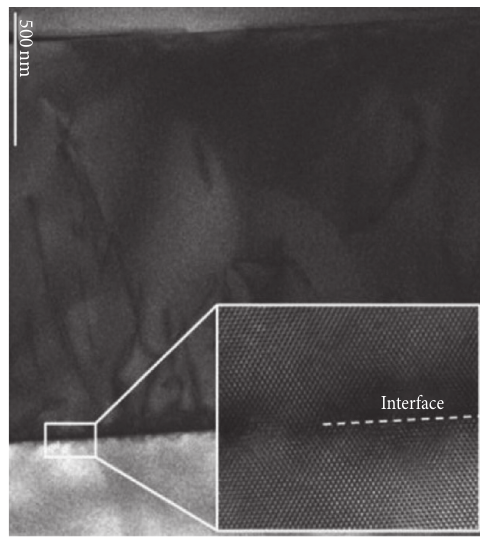
Figure 3: Cross-sectional image by TEM.